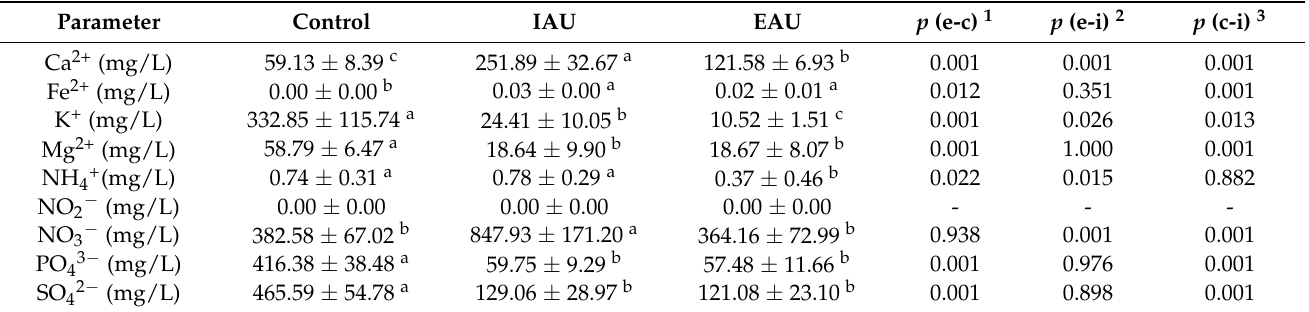
Table 4. Chemical water quality parameters of nutrient tanks with water from fertilized tap water (Control) and fish effluents from the intensive aquaculture unit (IAU) and extensive aquaculture unit (EAU) (mean ± SD, n =